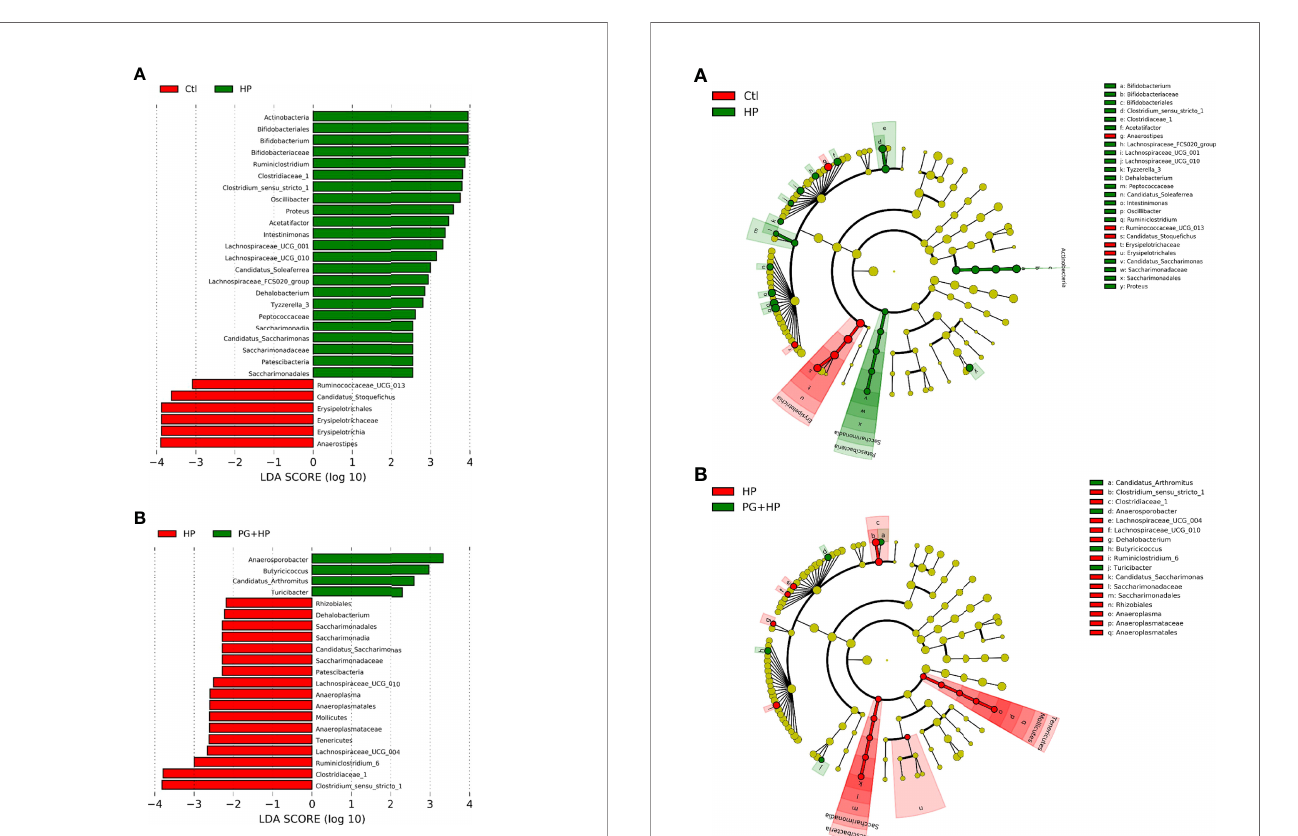
FIGURE 6 | Circular taxonomic and phylogenetic tree of the gut microbiota diversity. Compared the effect of P. goldsteinii MTS01 and H. pylori altered microbiota composition in each group. Cladogram showed enriched taxa of gut microbiome in mice treated with (A) control and H. pylori ; (B) H. pylori and P. goldsteinii MTS01+ H. pylori .